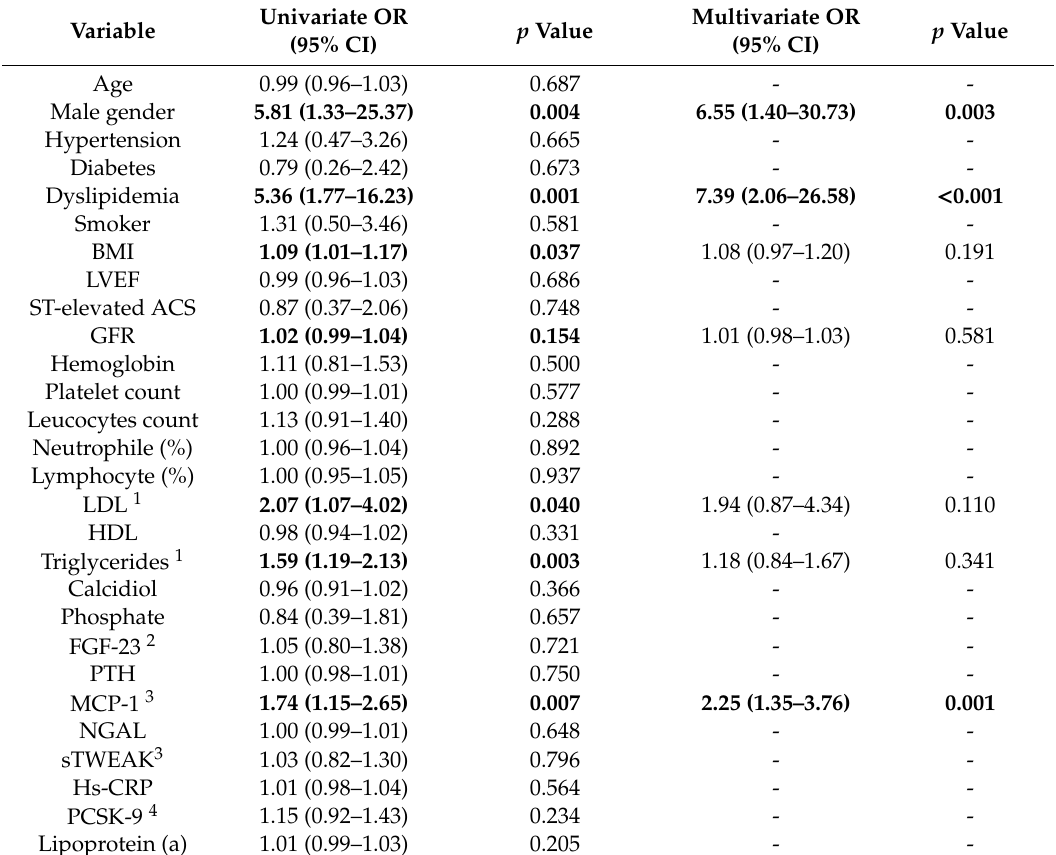
Table 2. Logistic regression analysis for predictors of coronary artery